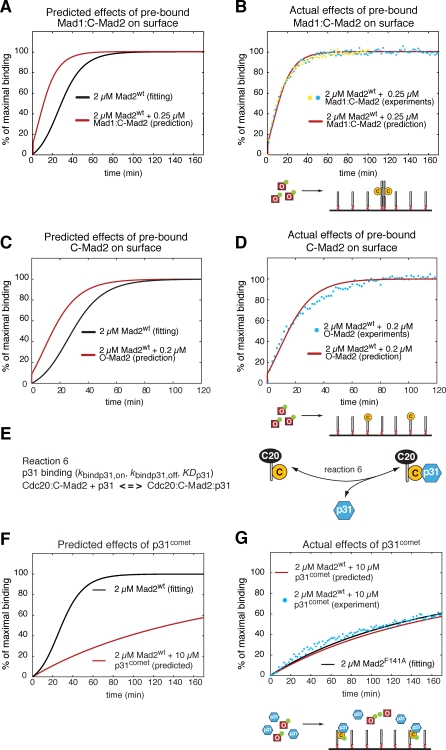
Testing the Predictions of the Model(A) The time course of accumulation of Mad2wt (at 2 μM concentration) on a surface exposing Cdc20 is shown through the fit to the experimentally determined binding curves (black line). The red line is a prediction of the effects on Mad2wt binding to the surface due to the presence of 0.25 μM Mad1:C-Mad2 interspersed with Cdc20. The prediction is that the reaction is accelerated because Mad2wt can now rapidly bind to C-Mad2 in the Mad1:C-Mad2 complex, as a consequence of which, its transfer to Cdc20 is accelerated. Parameters are listed in Table 1, equations in Tables S1 and S2.(B) Experimental determination (curves defined by yellow and blue dots) of the binding of 2 μM O-Mad2wt to the Cdc20-exposing surface in the presence of Mad1:C-Mad2. There is excellent agreement between the prediction (red curve, the same shown in [A]) and the experiments. Red squares indicate O-Mad2; yellow circles indicate C-Mad2; green dots indicate fluorescent labels.(C) Similarly to (A), the model predicts that the rate of Cdc20:C-Mad2 binding can be accelerated by the presence of preformed Cdc20:C-Mad2. Black solid line: the fit to the experimentally determined binding curves; in red: the predicted timing of Cdc20:C-Mad2 formation in presence of pretreatment of the surface with 0.2 μM Mad2wt. Parameters are listed in Table 1, equations in Tables S1 and S2.(D) Experimental results confirm the prediction of the model. The chamber was pretreated with 0.2 μM nonfluorescent Mad2wt until the reaction reached equilibrium. The remaining Mad2wt was washed from the chamber, and 2 μM fluorescent Mad2wt were added in solution. There is excellent agreement between the prediction (red curve, the same shown in [A]) and the experiments (blue dots).(E) The role of p31comet in the SAC is based on its ability to interact with C-Mad2 bound to either Mad1 or Cdc20 in a manner that is competitive with the binding of O-Mad2. p31comet is a negative regulator of the SAC [21,29,37,47].(F) The black line shows the same time course of accumulation of Mad2wt (at 2 μM concentration) on a surface exposing Cdc20 that was shown in (A). The red line indicates a prediction of the effects on Mad2wt binding to the surface exposing Cdc20 of adding 10 μM p31comet. (Parameters are listed in Table 1, equations in Tables S1 and S2.) The prediction is that the reaction is strongly delayed because p31comet binds tightly to the Cdc20:C-Mad2 complex on the surface and prevents the recruitment of additional Mad2wt through dimerization and catalysis.(G) The prediction in (D) is fully satisfied by experimental determination of the binding of 2 μM Mad2wt to Cdc20 in the presence of 10 μM p31comet (blue dots). The time course of Mad2wt is strongly delayed by p31comet, and it now resembles the rate observed in the presence of 2 μM Mad2F141A, whose fitting is shown with a black line. P31, p31comet.